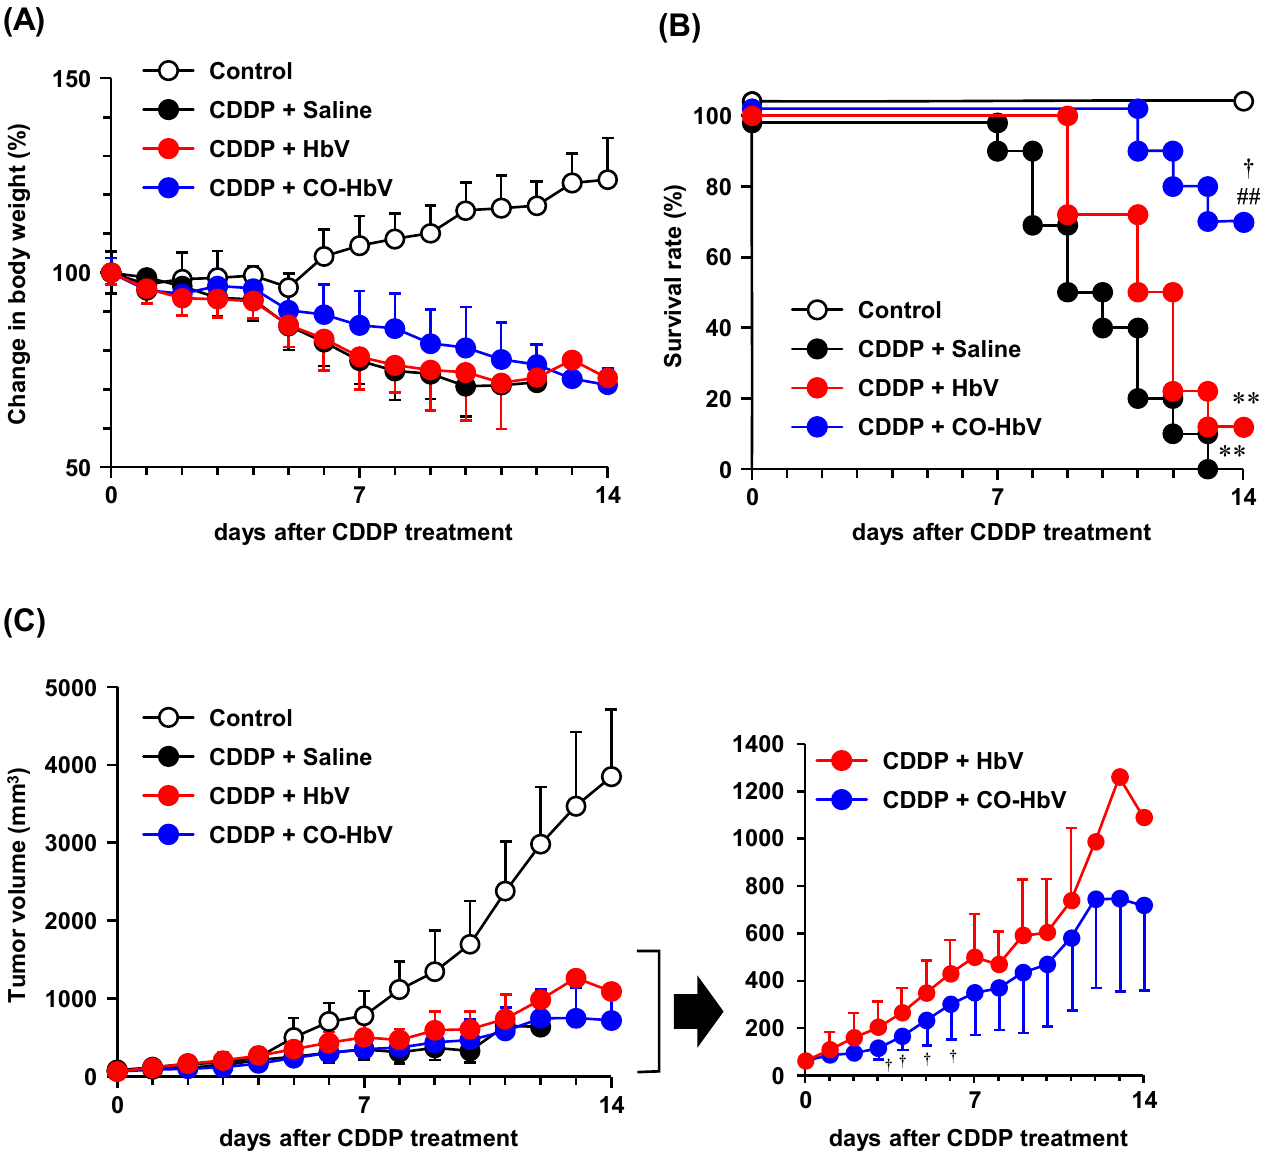
Figure 6. Effect of carbon monoxide (CO)-loaded Hemoglobin-vesicle (CO-HbV) on the anti-tumor efficacy of the conventional cisplatin (CDDP) treatment in B16-F10 bearing mice. The profiles of ( A ) body weight, ( B ) survival rate and ( C ) tumor volume until 14 days after the commencement of CDDP administrations. The data represent the mean ± S.D. ( n = 10). ** p < 0.01 vs. Control, ## p < 0.01 vs. Saline, † p < 0.05 vs. HbV. The body weight differences of saline, HbV, and CO-HbV groups were significant ( p < 0.01) from day 2 to day 10, from day 2 to day 11, and from day 2 to day 14, respectively, compared to the control group. The tumor volume of saline, HbV and CO-HbV group were significantly different ( p < 0.01) from day 6 to day 10, from day 6 to day 11, and from day 6 to day 14, respectively, compared to the control group.